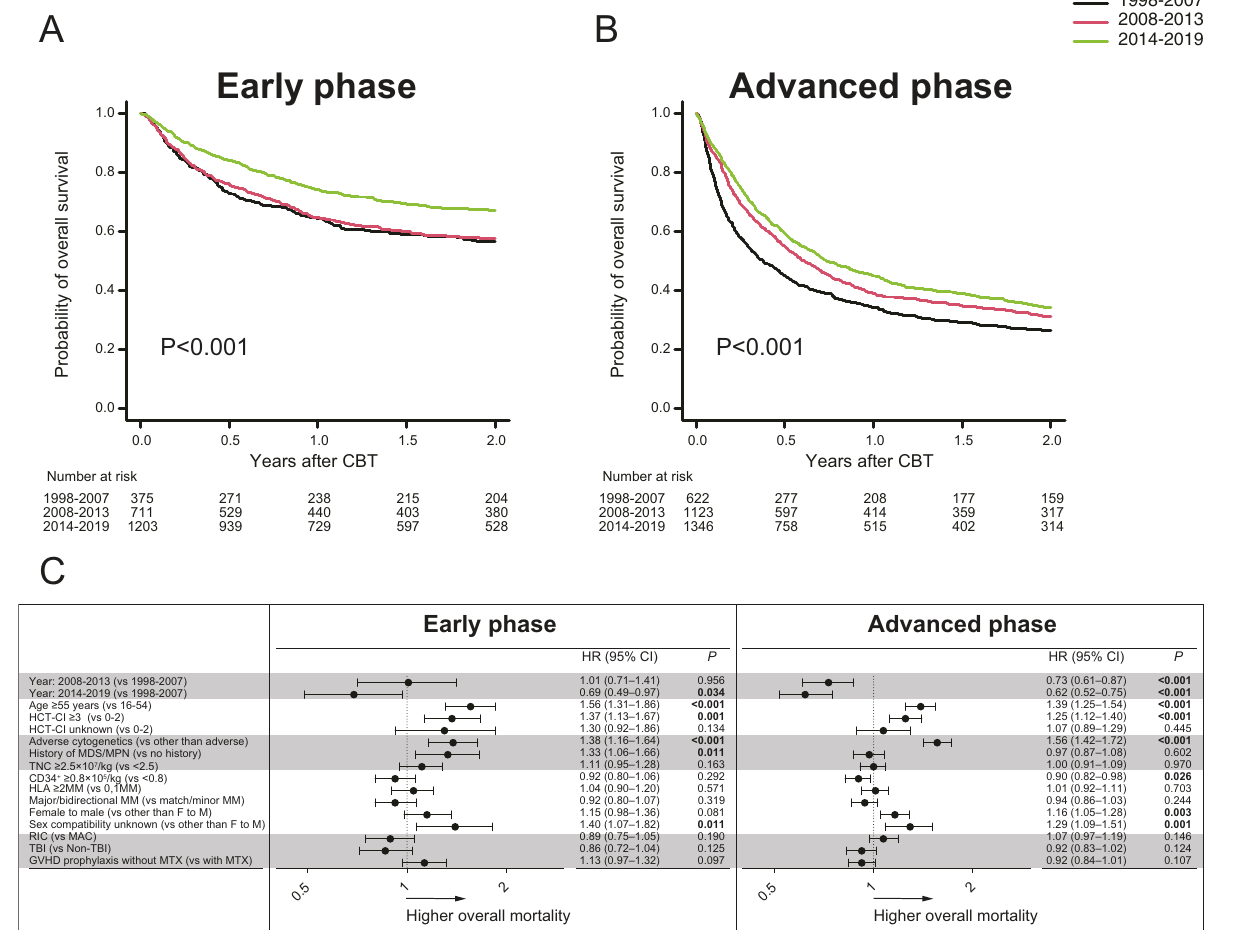
Fig. 2 Overall survival after CBT according to disease status at CBT. The probabilities of overall survival after CBT according to the three time periods in patients with early phase at CBT ( A ), or advanced phase at CBT ( B ). Forest plots of the adjusted hazard ratios (HR) and 95% con fi dence intervals (CI) of overall mortality among each cohort in the multivariate analysis ( C